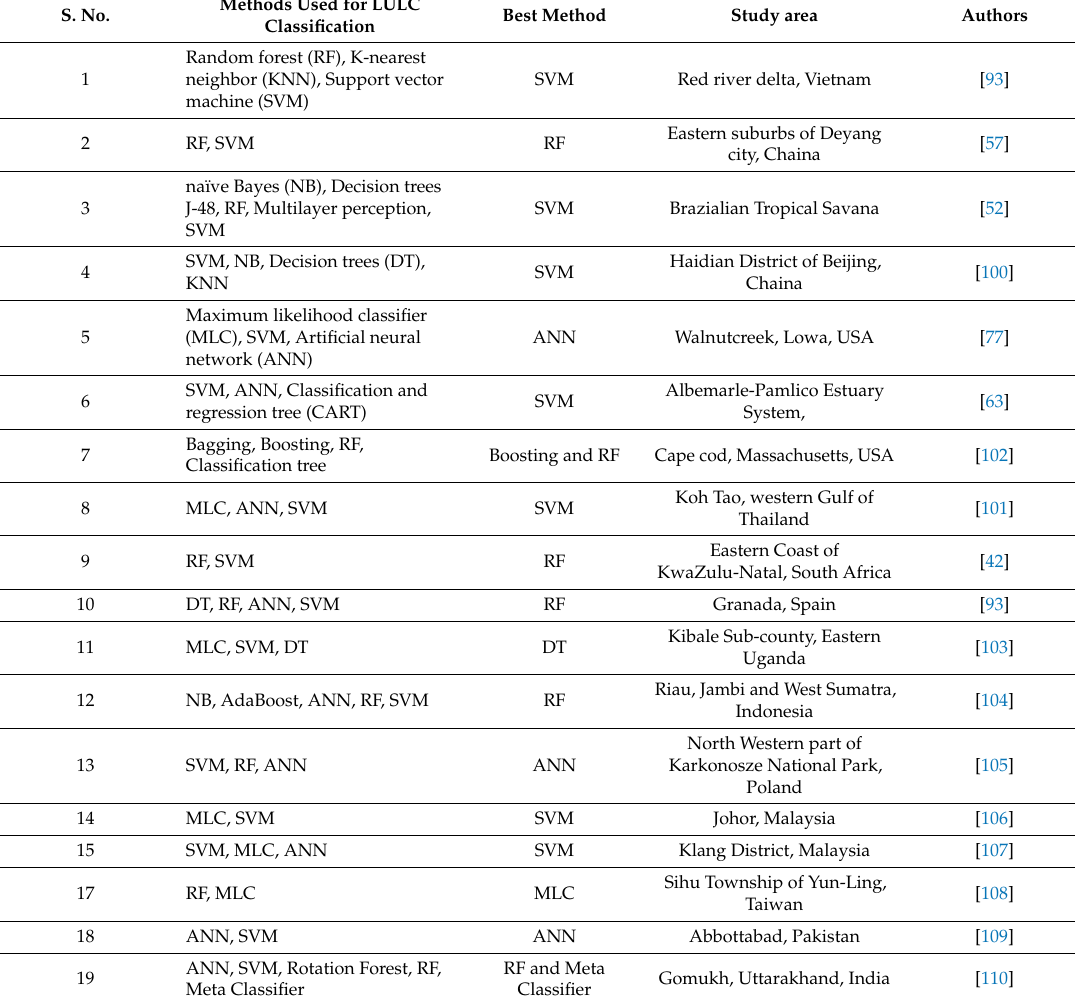
Table 7. Suitability of classifier in LULC modelling as per the previous